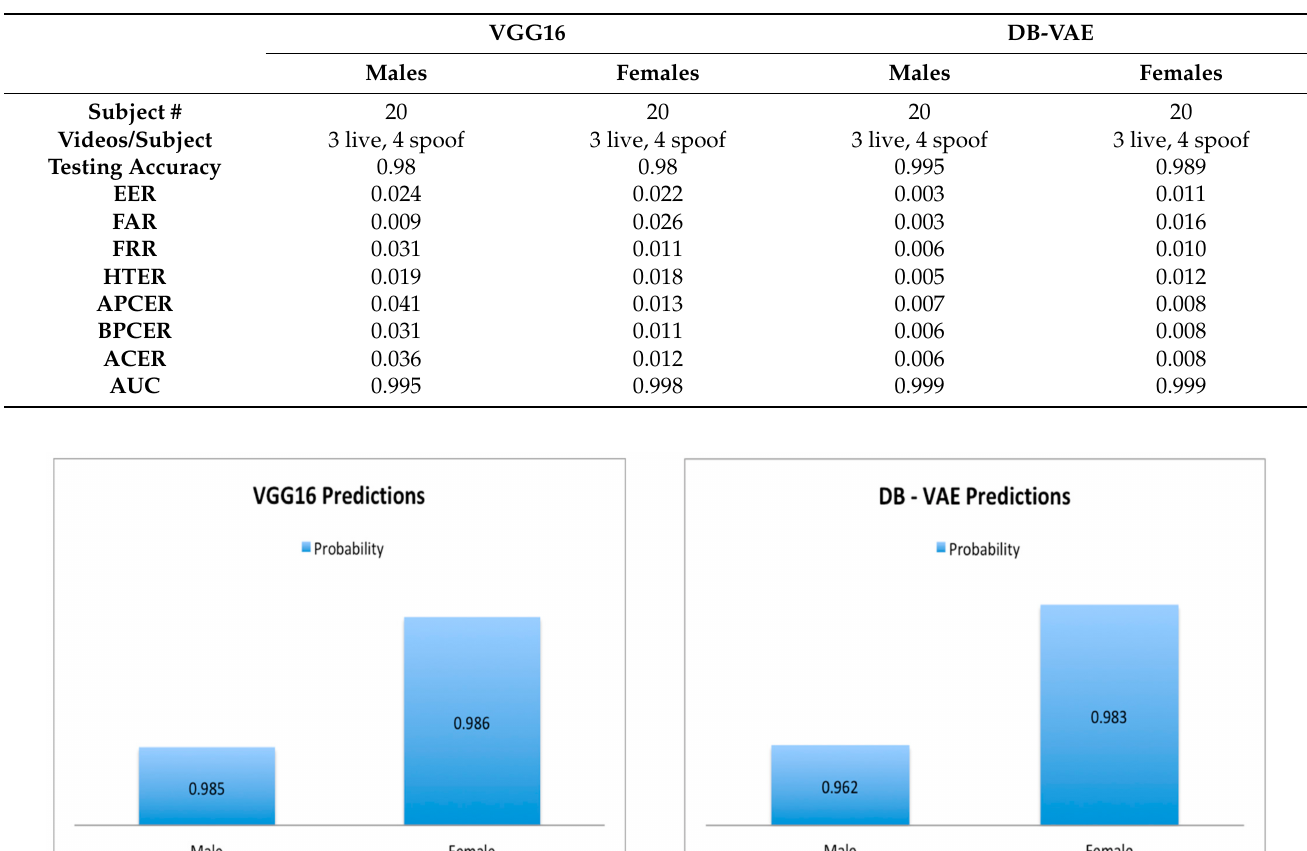
Table 6. Results for VGG16’s experiment and DB-VAE experiment.